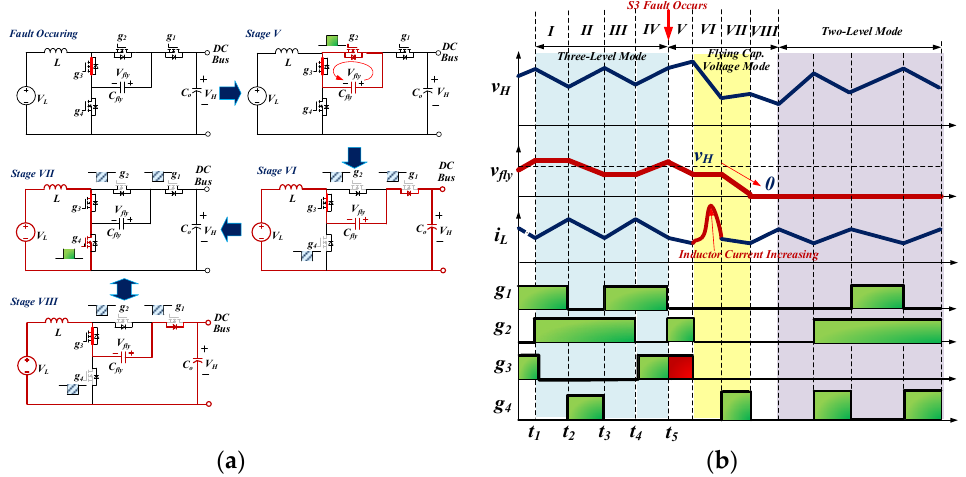
Figure 10. Short-circuit fault analysis (V L > 0.5 V H ). ( a ) The stages when S 3 is short-circuited; ( b ) stage analysis.